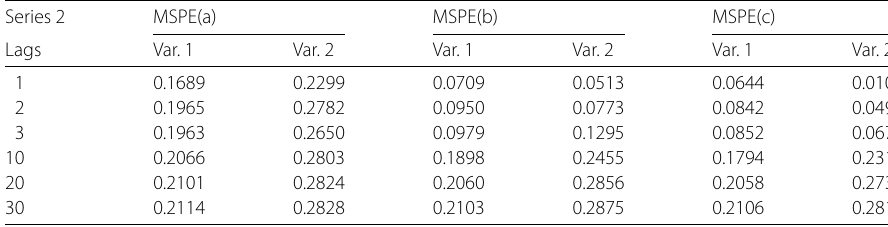
Table 2 VAR(3) model (Series 2)